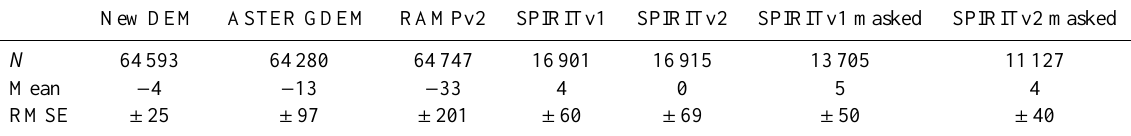
Table 2a. Mean elevation di ff erences from ICESat across the new DEM. N is the number of ICESat points. The mean di ff erence from each ICESat point is measured at height with respect to the EGM96 Geoid and the root mean square error (RMSE) is shown in metres.